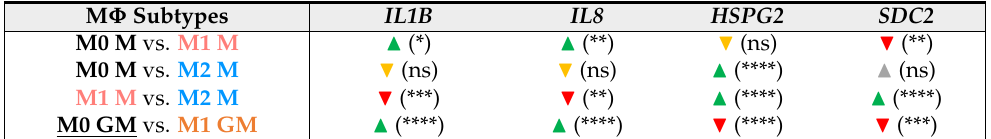
Table 2. Summary of the results from the genotypic characterization of the M Φ subtypes generated in this study. M Φ generation was performed using M-CSF (M) or GM-CSF (GM), while activation was performed with IFN- γ /LPS (M1), IL-4 (M2), or with no additive (M0). Data were analyzed using one-way ANOVA, followed by Tukey’s multiple comparison tests: ns (not significant), p < 0.05 (*), p < 0.01 (**), p < 0.001 (***), p < 0.0001 (****). Comparisons shown refer to the latter M Φ subtype. Significant relative expression increases are indicated by the symbol “ (cid:78) ”, and decreases by the symbol “ (cid:72) ”. Nonsignificant increases or reductions are indicated by the symbols “ (cid:78) ” and “ (cid:72) ”,